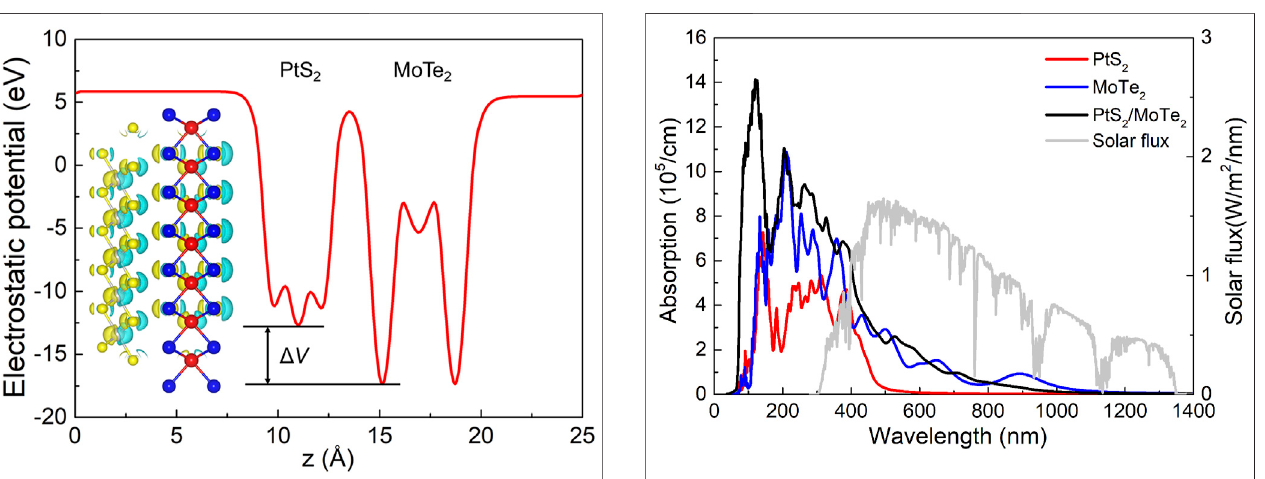
FIGURE 5 | The potential drop between the interface of the PtS 2 /MoTe 2 vdW heterostructure; the inset represents the charge density. The isosurface lever was set at